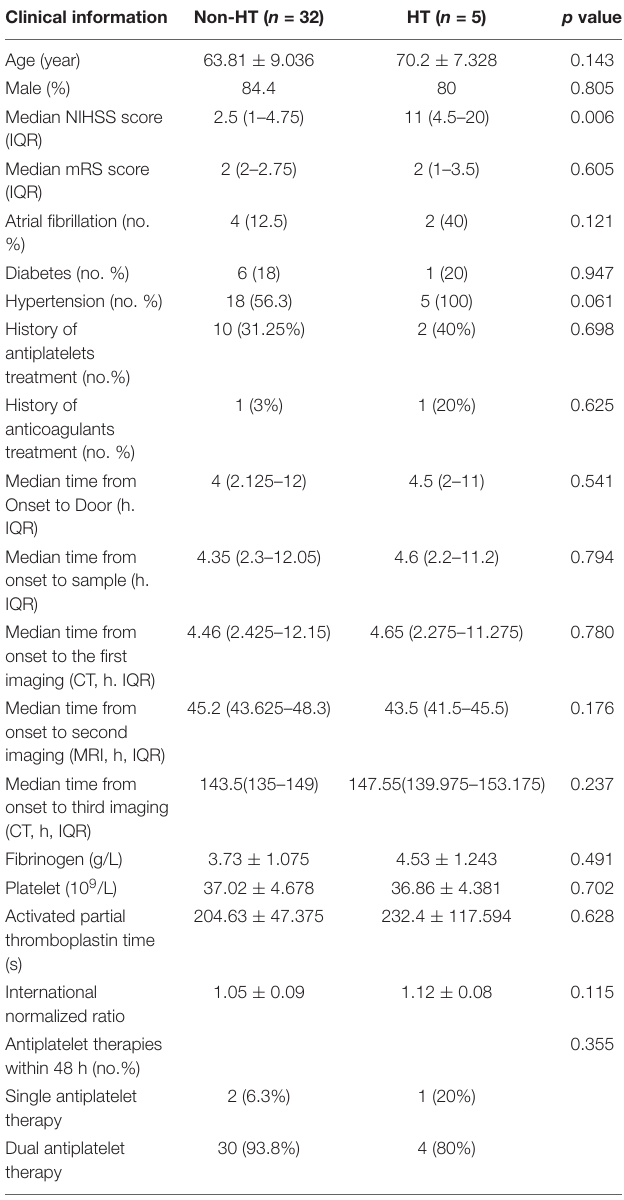
TABLE 2 | Baseline characteristics of HT and non-HT patients in enrolled cases. Clinical